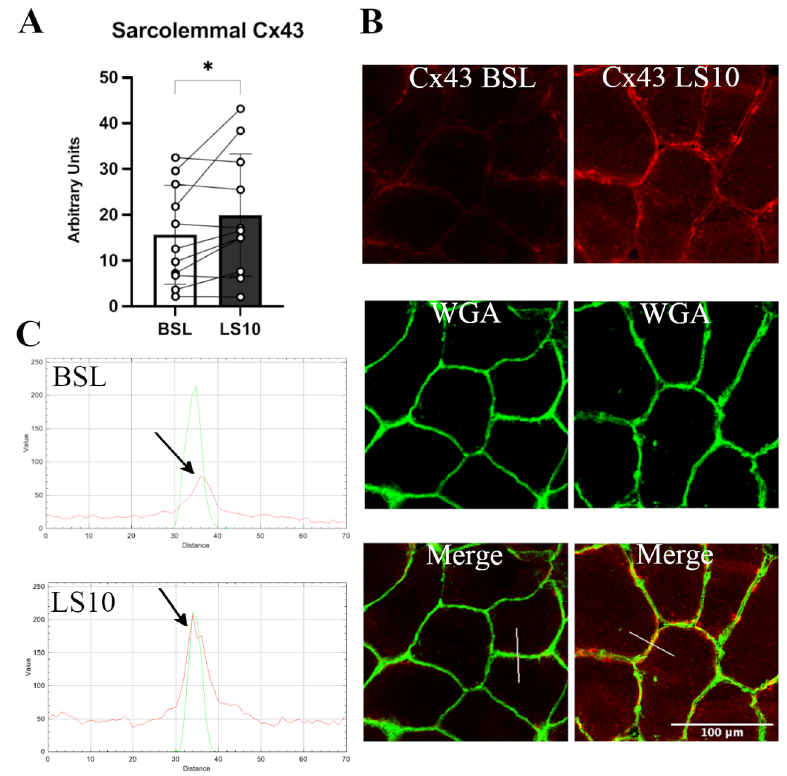
Figure 2. ( A ) Histogram showing average fluorescence units of Cx43 along the sarcolemma. Error bars represent standard deviations. The asterisk (*) indicates statistical significance at p < 0.05. ( B ) Typical immunostaining of Cx43 was obtained at baseline and after 10 days of ULLS. In the middle, the WGA signal detects N-acetylglucosamine and N-acetylneuraminic acid (sialic acid) residues of the sarcolemma. In the bottom panels, the merges between the two channels are reported. ( C ) RGB profiles of the immunostaining of Cx43. A line (width 5) has been drawn on the merge images (shown as a white line in the merge images), and RGB profiles were detected along the line. The peaks indicated by the arrows represent the green peak of the WGA signal referring to the sarcolemma fluorescence and the red peak referring to the Cx43 staining. A red peak is present only in the ULLS staining, proving its sarcolemmal upregulation. Intracellular fluorescence intensities in BSL and ULLS panels are different due to increased intracellular staining of Cx43 after ULLS. n = 11 male subjects; paired two-tailed t -test. Confocal microscope Leica SP5; 20×.